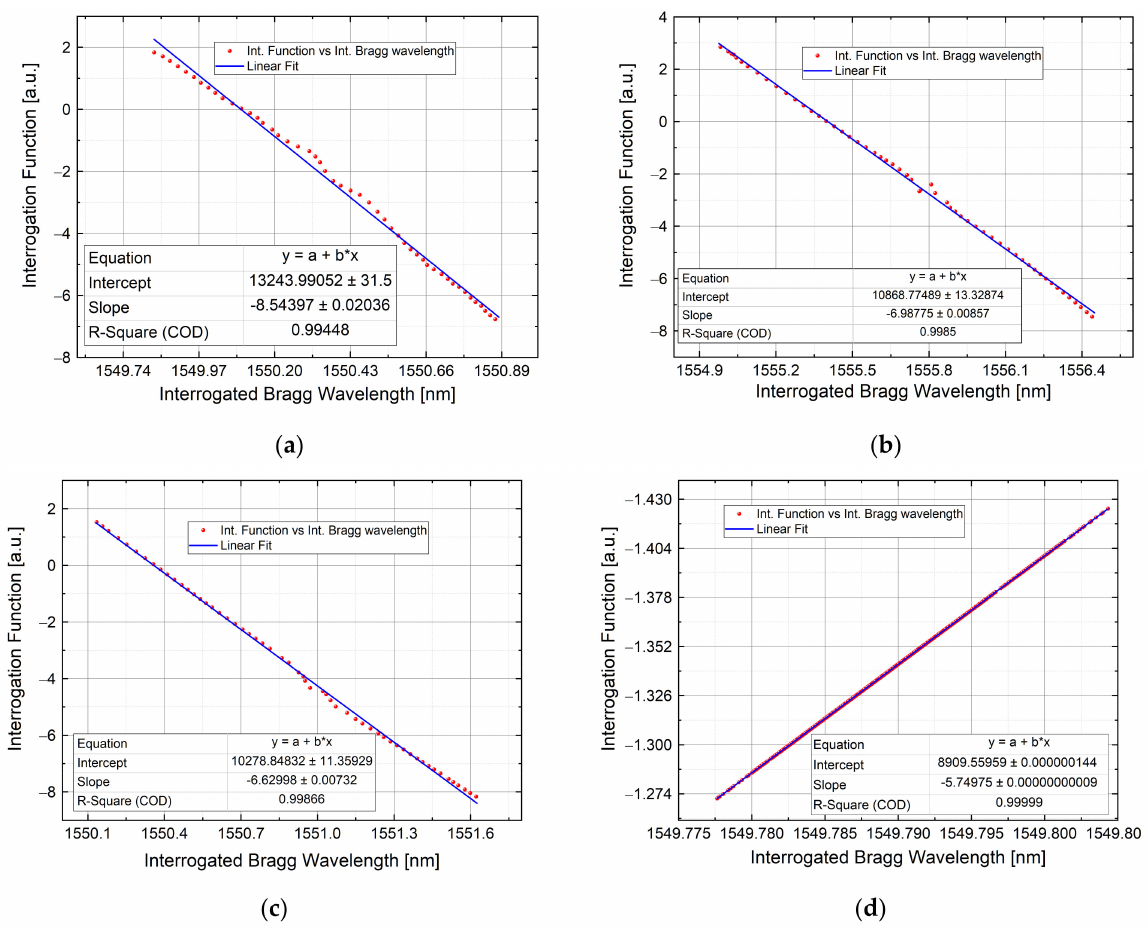
Figure 13. Interrogated Bragg wavelength versus Interrogation Function about 200 pm FWHM FBG during static measure- ment described in Section 4.1.1 ( a ); about 315 pm FWHM FBG during static measurement described in Section 4.1.2 ( b ); about 500 pm FWHM FBG during static measurement described in Section 4.1.3 ( c ); about 200 pm FWHM FBG during high-speed measurement described in Section 4.3 ( d